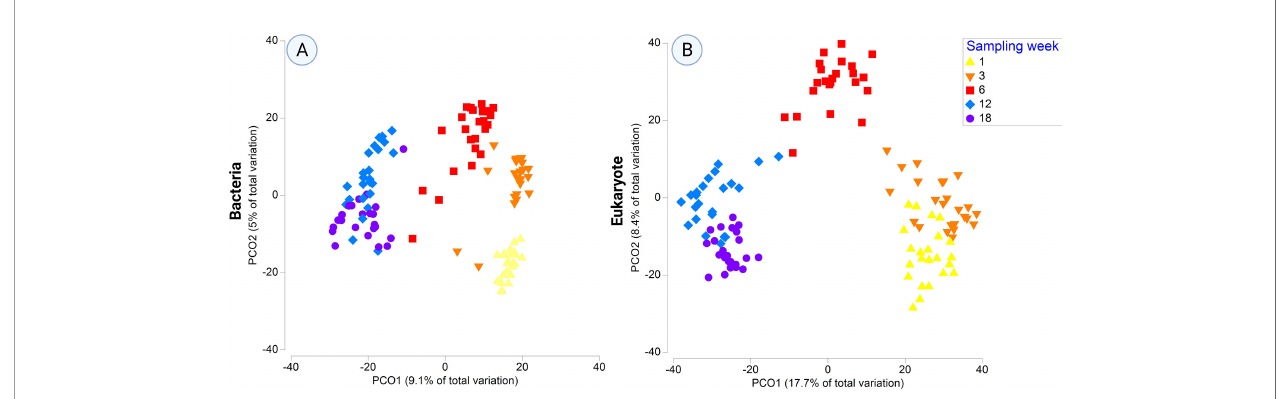
FIGURE 3 | Principal Coordinates Analysis (PCoA) plot of (A) bacterial 16S rRNA gene and (B) eukaryotic 18S rRNA gene data, based on fourth-root transformed data and Bray-Curtis dissimilarity matrix. Colors represent the various